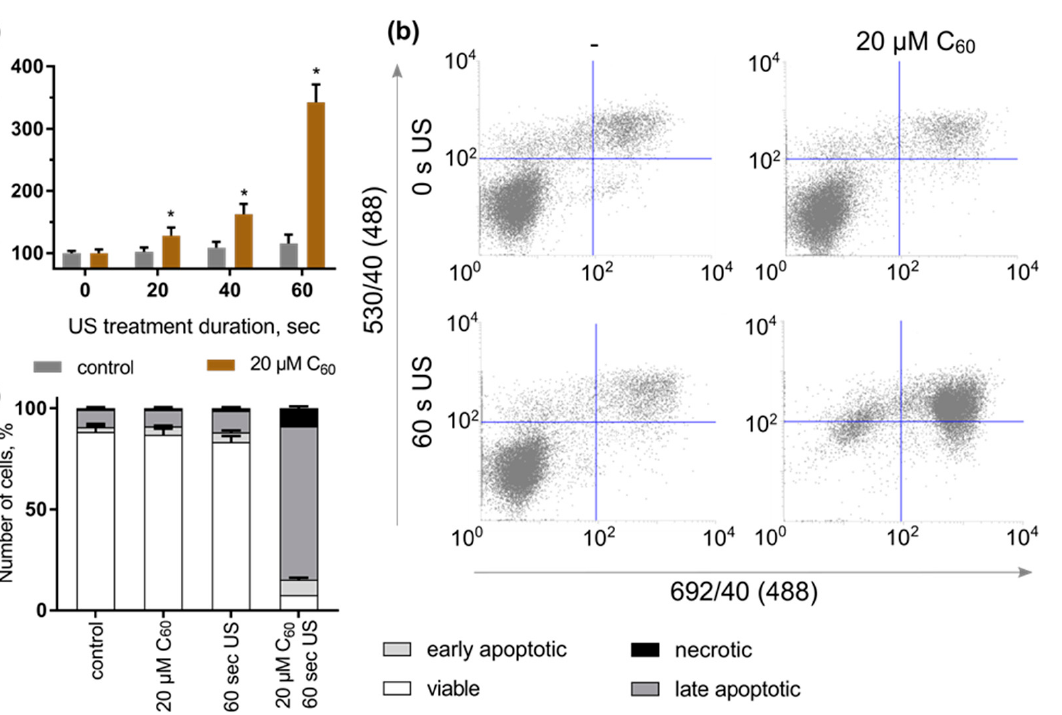
Figure 6. Apoptosis induction in HeLa cells by sonodynamically excited C 60 : ( a )—Caspase 3/7 activity, *— p ≤ 0.01 in comparison with the viability of cells, treated with the respective duration of US; ( b )—FACS histograms of HeLa cells, stained with Annexin V-FITC/PI (in each panel the lower left quadrant shows the content of viable, upper left quadrant—early apoptotic, upper right quadrant— late apoptotic, lower right quadrant—necrotic cells populations); ( c )—Quantitative analysis of cell population content, differentiated with double Annexin V-FITC/PI staining.